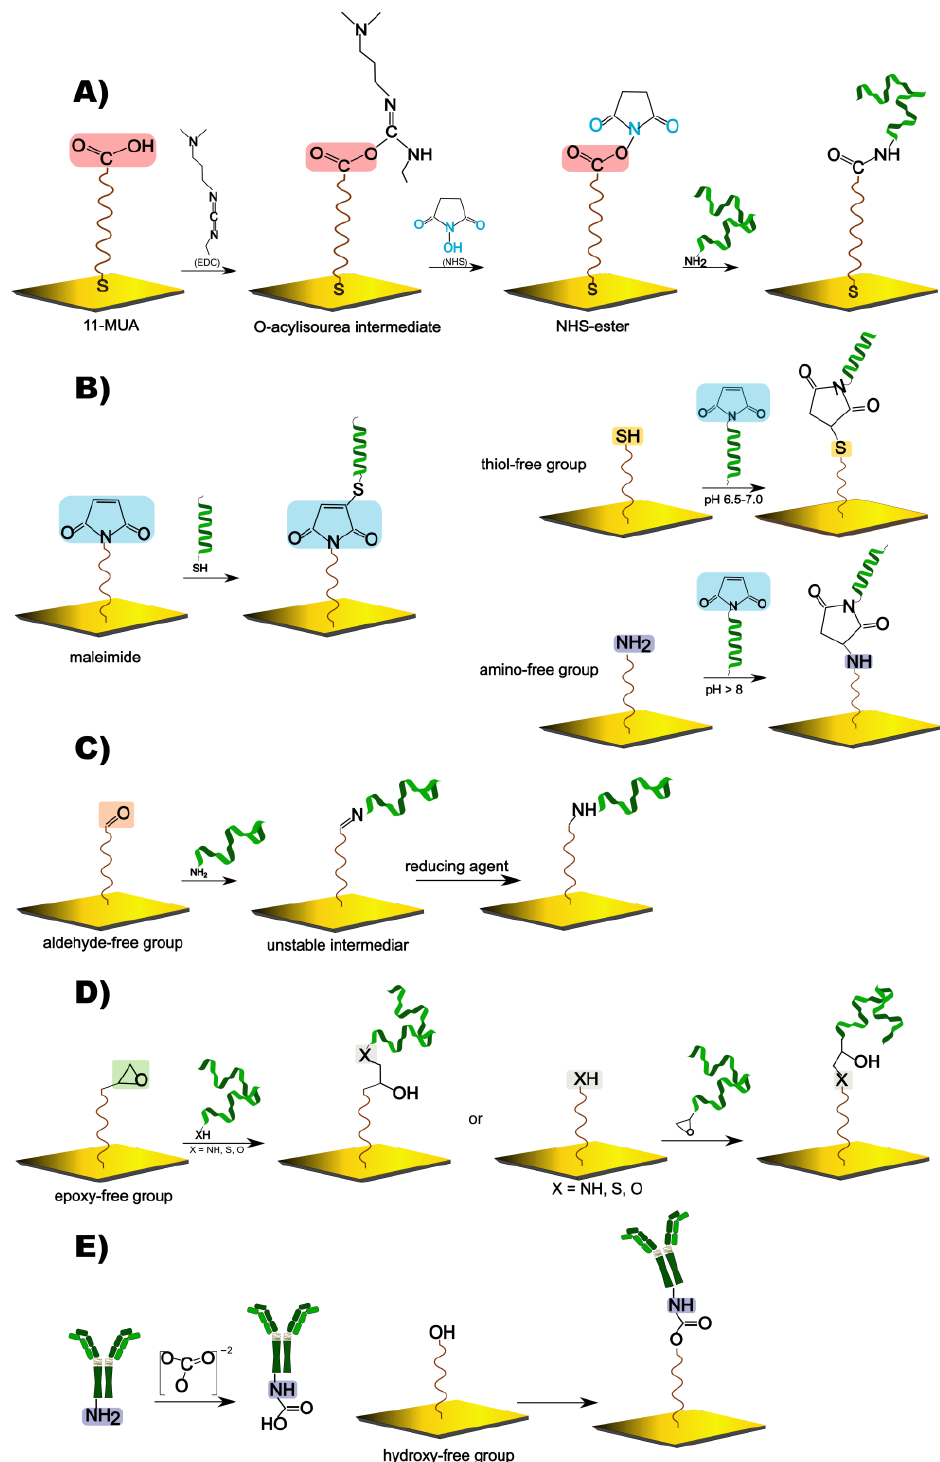
Figure 3. Random covalent immobilization strategies: ( A ) EDC/NHS immobilization. The EDC/NHS chemistry has 2 main steps. First, the carboxyl group is activated by EDC and is turned into an O–acylisourea, an unstable intermediate. NHS reacts fast with this intermediate, forming an active NHS-ester that subsequently reacts with the primary amine groups of the ligand; ( B ) maleimide reaction with thiol or primary amine groups; ( C ) aldehyde reaction with available amine group; ( D ) epoxy reaction with an available amine, thiol, or hydroxyl group; ( E ) amine reaction with an available hydroxyl group in presence of carbonate.